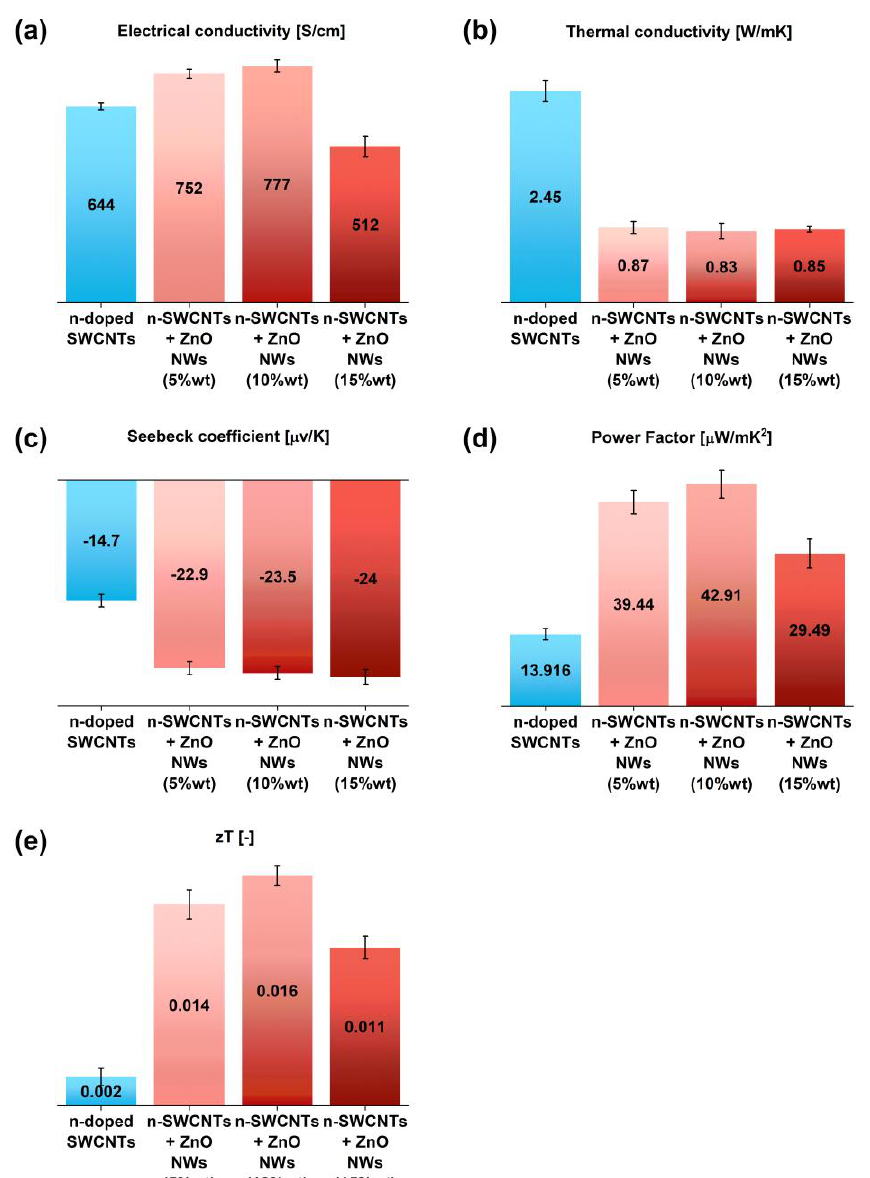
Figure 5. The influence of the incorporation of ZnO NWs (5 wt%, 10 wt%, and 15 wt% with respect to SWCNTs) into n-doped SWCNT films on the values of ( a ) electrical conductivity, ( b ) thermal conductivity, ( c ) Seebeck coefficient, ( d ) Power Factor, and ( e ) Figure of Merit. The results also suggest that the proposed solution is readily scalable (Figure 6c). Av- erage Seebeck coefficients (determined from the slopes of the linear fits shown in Figure 6b) show virtually no changes, regardless of the number of employed n–p pairs. Consequently, it should be possible to obtain much more thermopower by creating modules containing many more n–p pairs. Alternatively, several modules could be connected in parallel or in series to increase the magnitude of the produced current or electric potential,